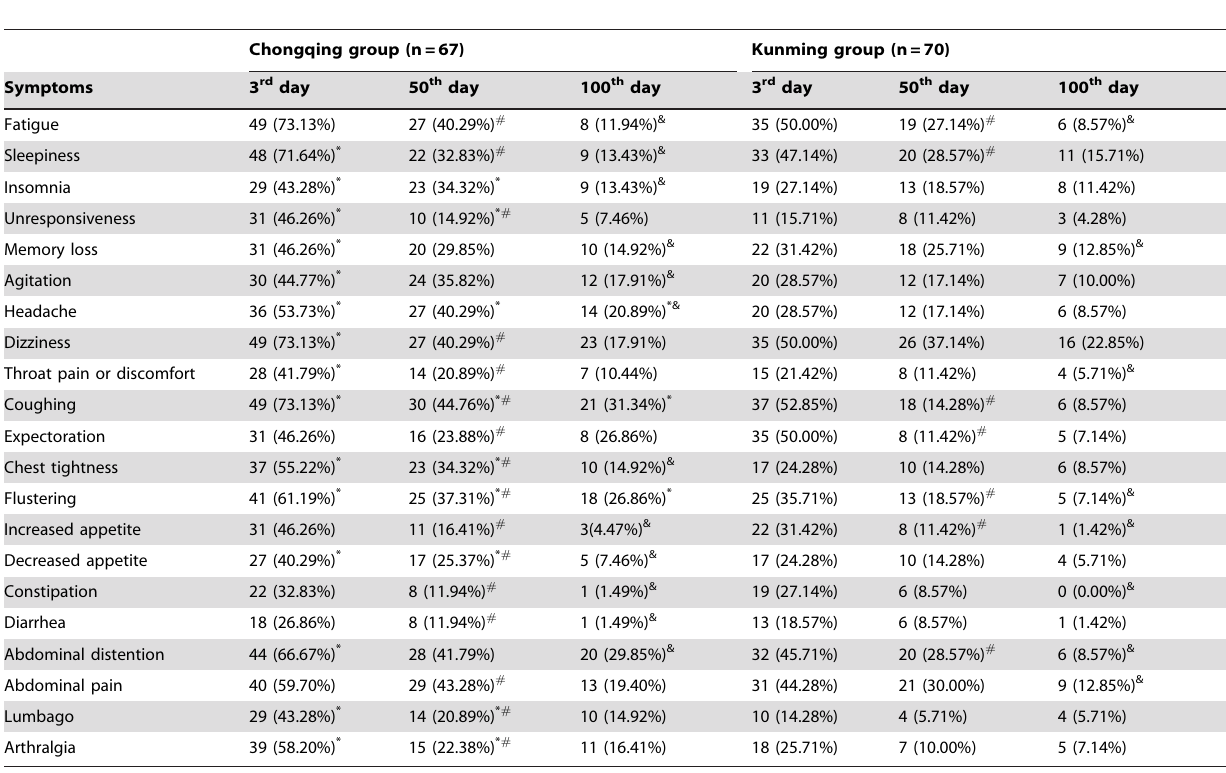
Table 3. Incidence of symptoms of subjects after returning to Chongqing or Kunming after visiting high altitudes.